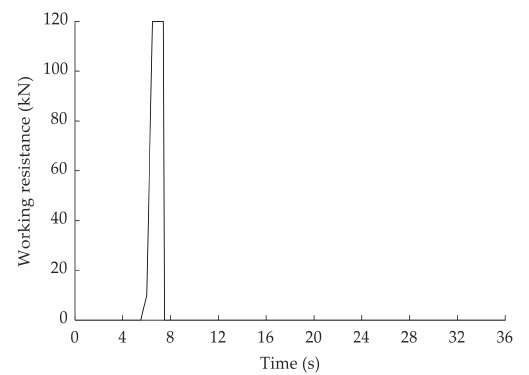
Figure 10. The working resistance of the loader.